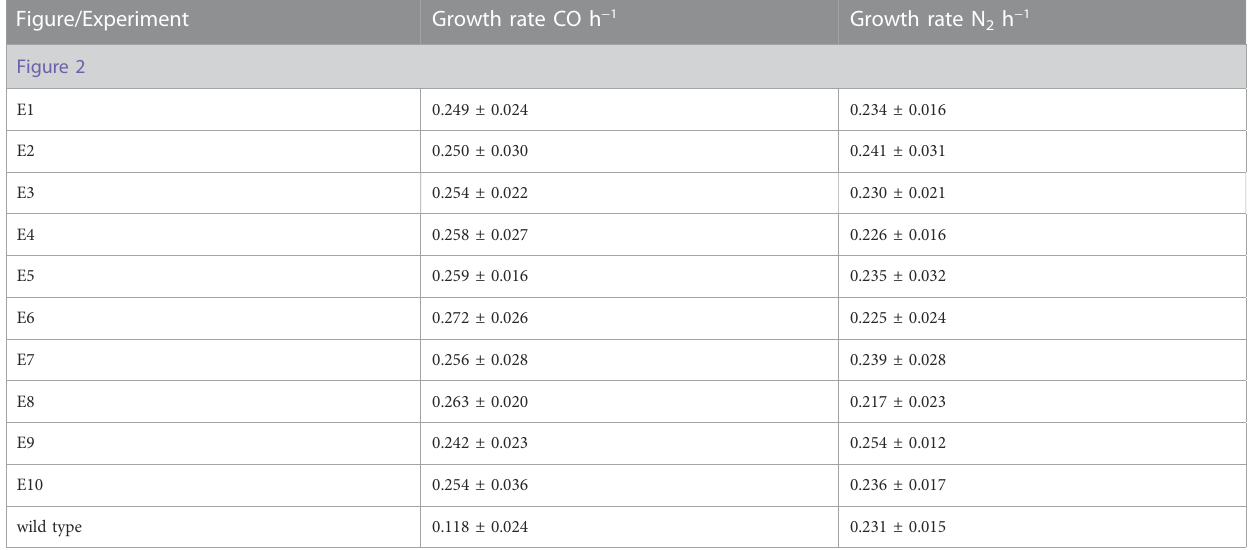
TABLE 2 Heterotrophic growth rates for evolved C. necator isolates E1 to E10 and wild type H16. Figure/Experiment Growth rate CO h − 1 Growth rate N 2 h − 1 Figure